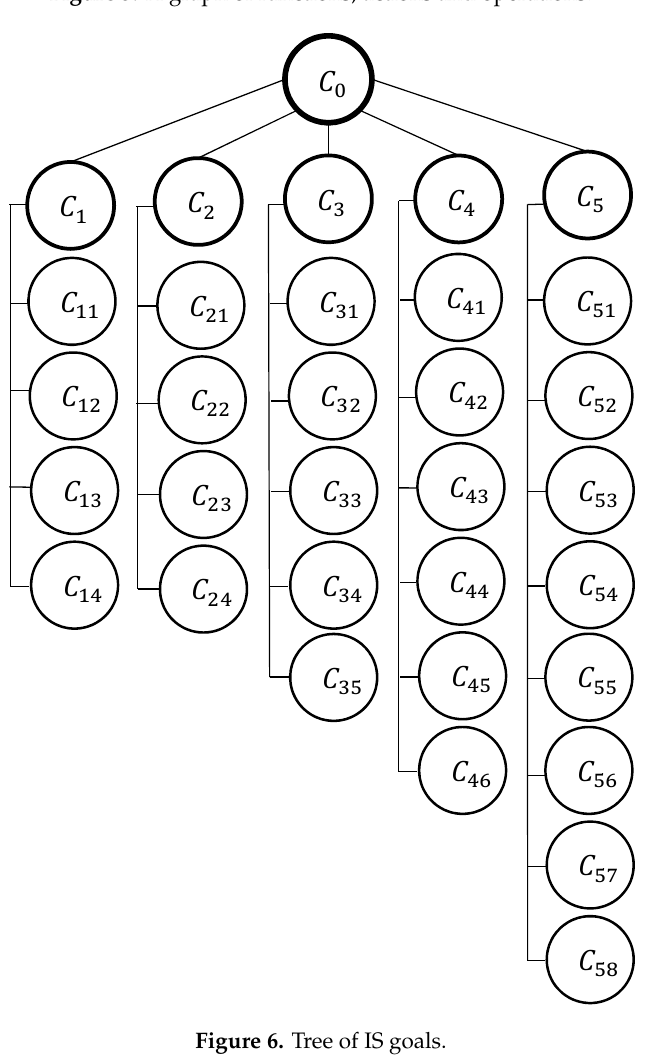
Figure 6. Tree of IS goals.